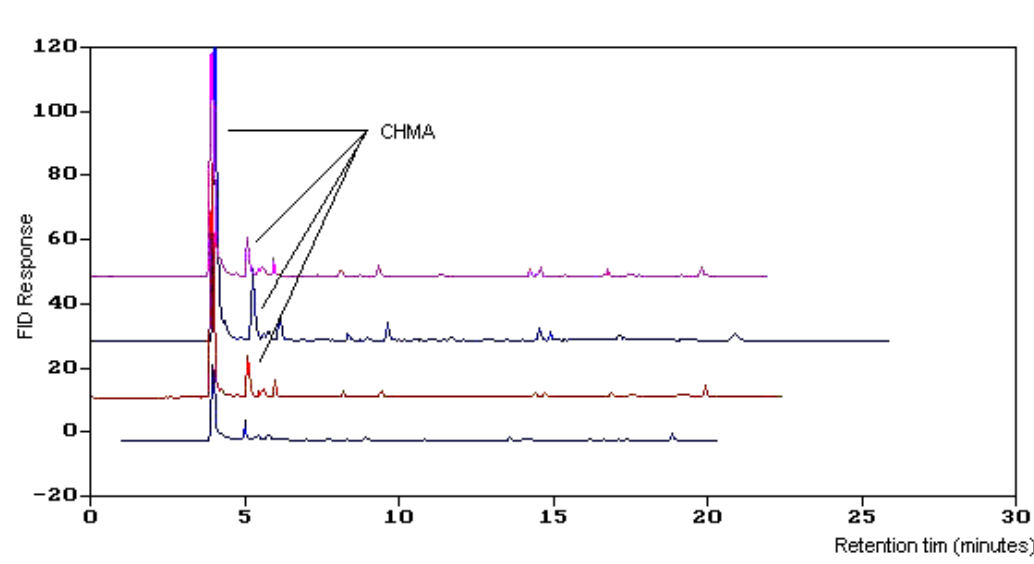
Fig. 4 Overlay: Pyrograms of Algae + CHMA at pyrolysis temperature 850 ◦ C. Colours: Blue = pure algae pyrolysis; Red = algae + CHMA after 1 st week; Dark blue = algae + CHMA after 2 nd week (the highest amount of CHMA); Light blue = algae + CHMA after 3 rd week. Column conditions: 30 m Sol Gel Wax capillary column: inner diameter, 0.25 mm, film thickness- 0.25 µ m (SGE, Australia). The column temperature was kept at 70 ◦ C for 2 minutes and programmed to 170 ◦ C at the increments of 10 ◦